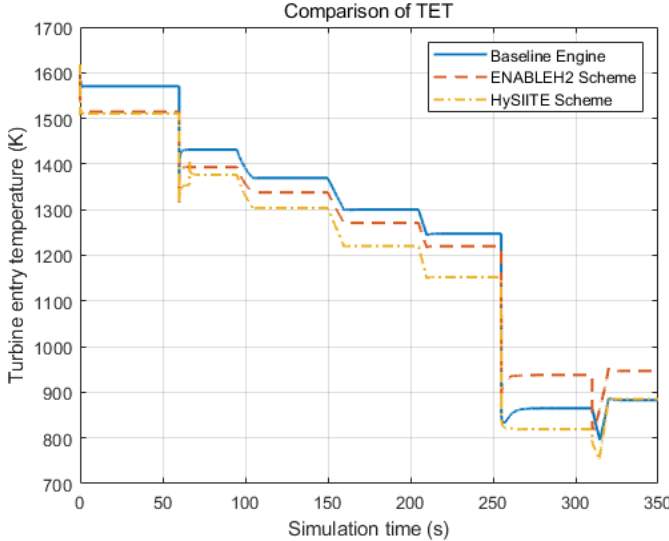
Figure 9. TET comparison of baseline engine, ENABLEH2 scheme, and HySIITE